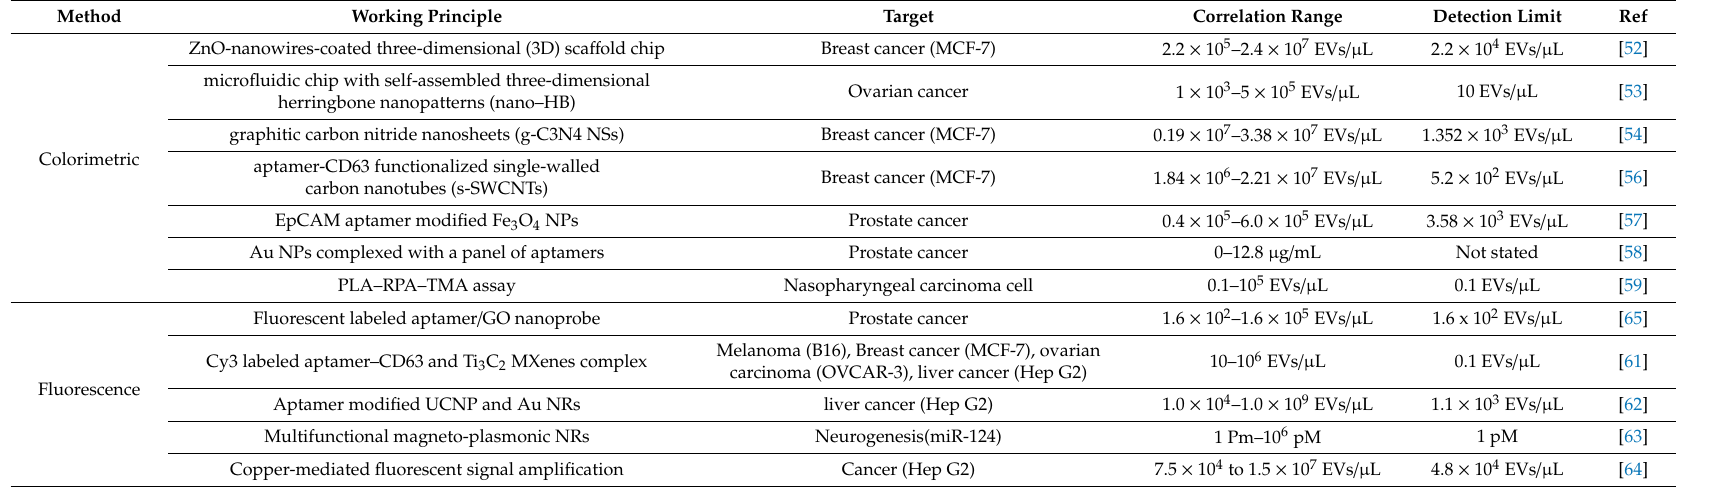
Table 2. Comparison of Colorimetric / Fluorescence-Based Bionano Sensors for EV